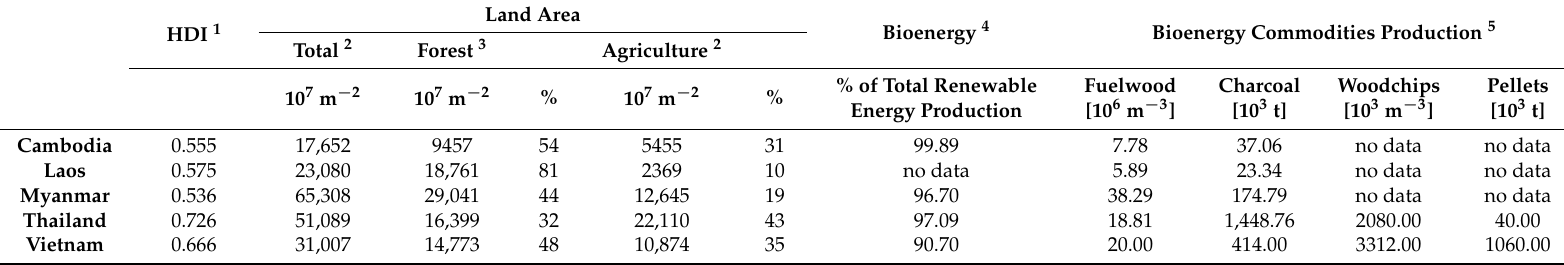
Table 1. Basic facts on land-use, current share of bioenergy, and bioenergy commodities in the ACMECS